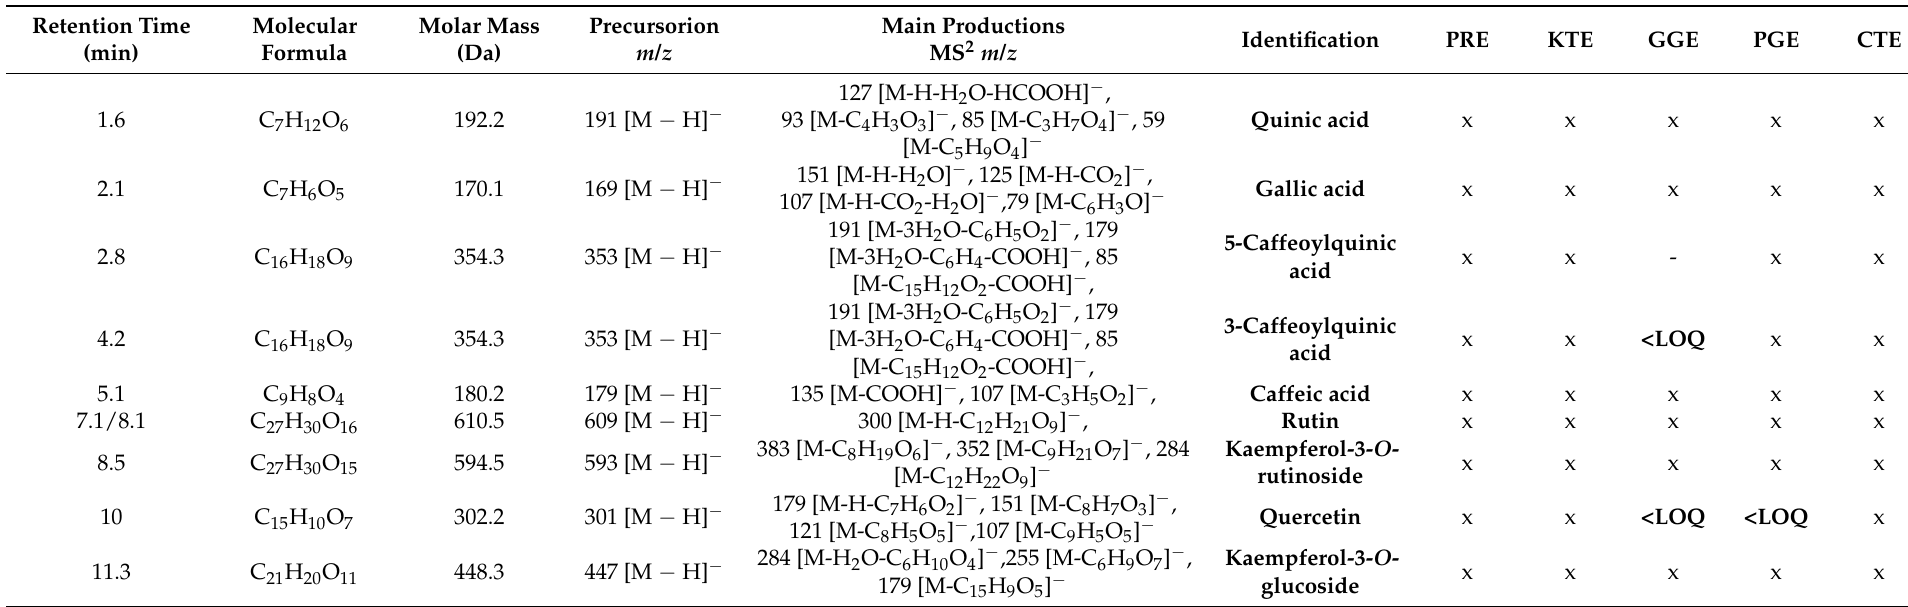
Table 1. Bioactive compounds detected using HPLC-ESI-MS in PRE, KTE, GGE, PGE and CTE extracts.